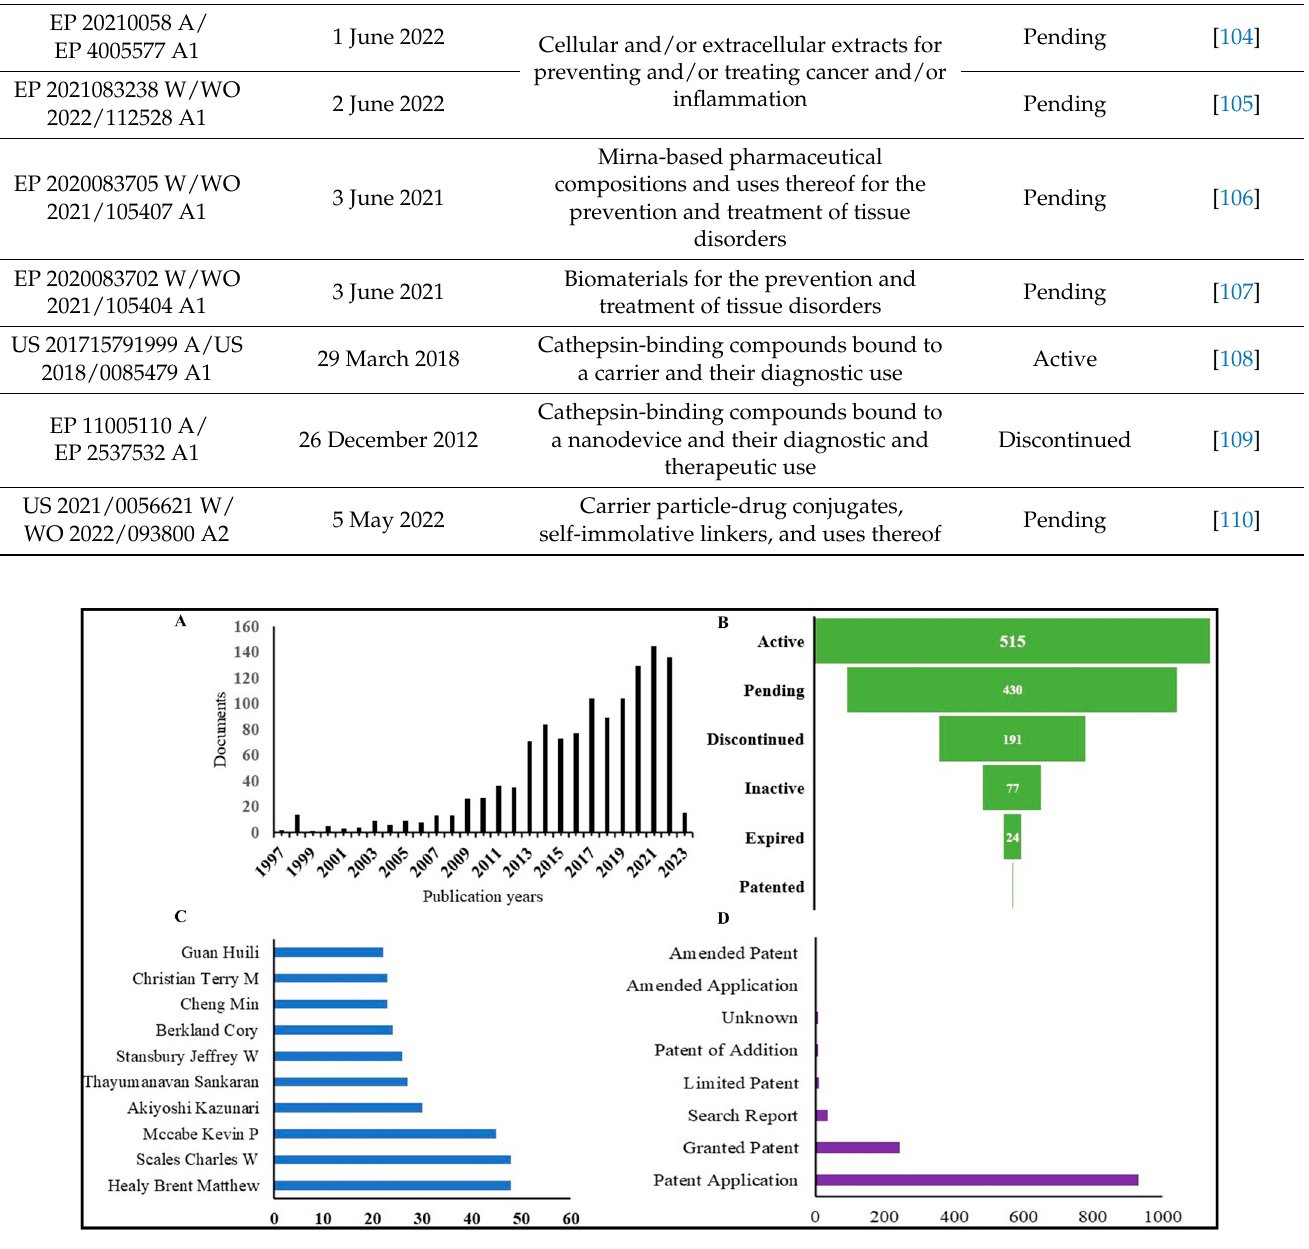
Figure 4. The patent situation on nano-gels in the management of skin cancer. ( A ) Patents applied year wise ( B ) Legal status of patents applied ( C ) Major Innovators applied for patents ( D ) Document type (Granted and applied data). Table 2. Patents on Nano-gel for Skin Cancer.